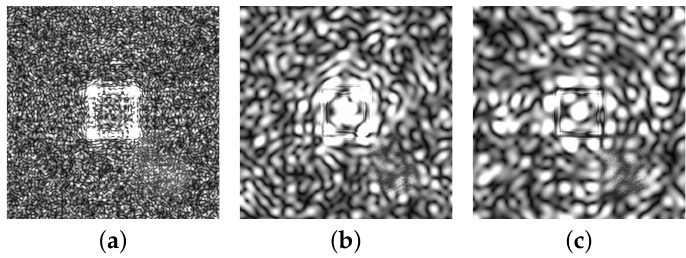
Figure 9. Examples of encryption results with the optimal scaling factor at the diffraction distances of